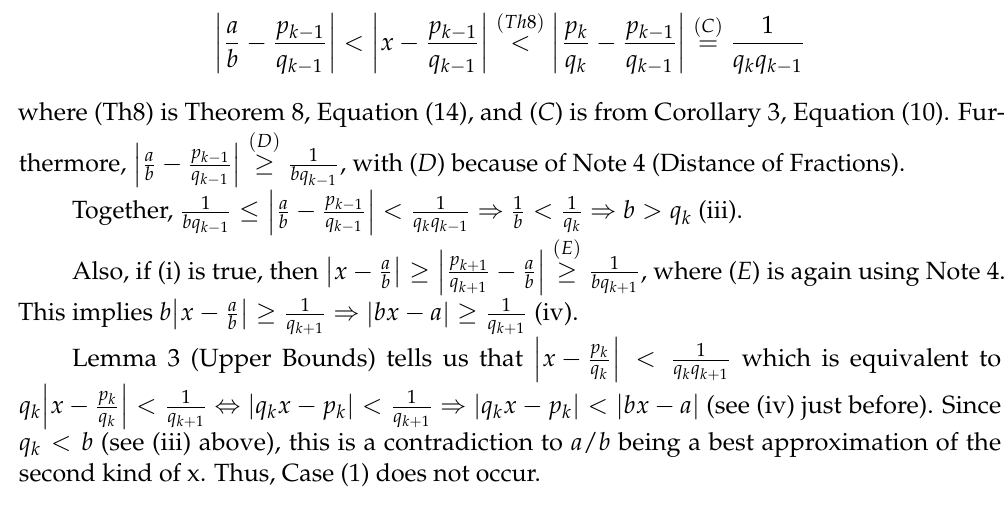
Figure 10. If a best approximation of the second kind is not a convergent, it is within the indicated grey shaded grey shaded areas.